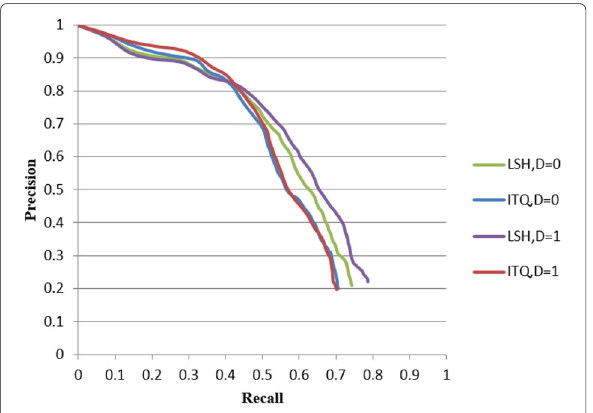
Fig. 9 Performance comparison for LSH and ITQ hashing